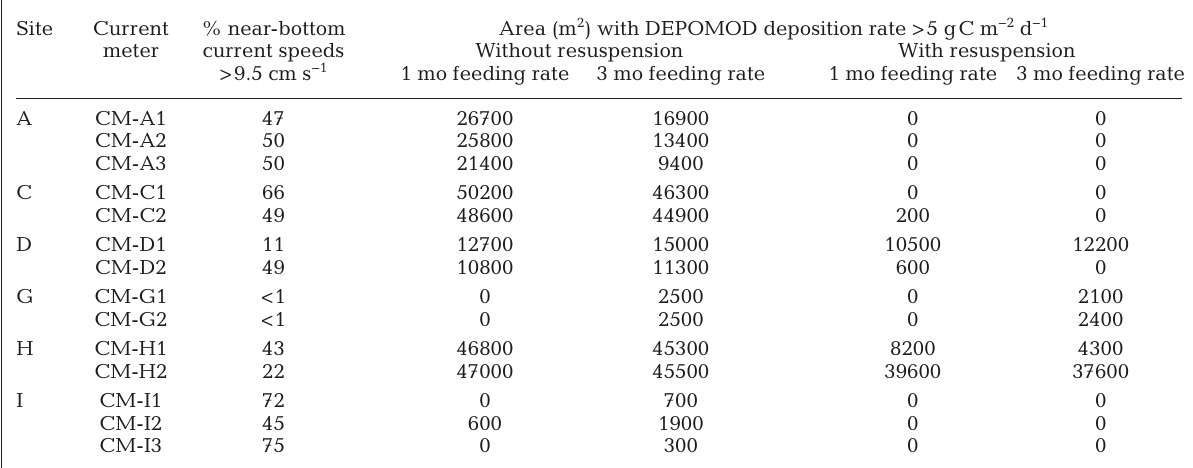
Fig. 4. Relationships between the DEPOMOD-predicted seafloor area with elevated impacts (deposition rate >5 g C m −2 d −1 ) (a,b) without and (c,d) with resuspension and (a) the median mid-depth current speed, (b) the average daily feeding rate per site during 1 mo periods including the sediment sampling date, (c) the percentage of near-bottom current speeds > 9.5 cm s −1 , and (d) the average daily feeding rate per site during 1 mo periods including the sediment sampling date. Areas are normal- ized relative to the total surface area of cages at each Table 6. Areas with elevated carbon deposition rates (>5 g C m −2 d −1 ) predicted using DEPOMOD at 6 study sites. Predictions were made without and with resuspension, using average daily feeding rates per cage during 1 and 3 mo periods ending near the date of sediment